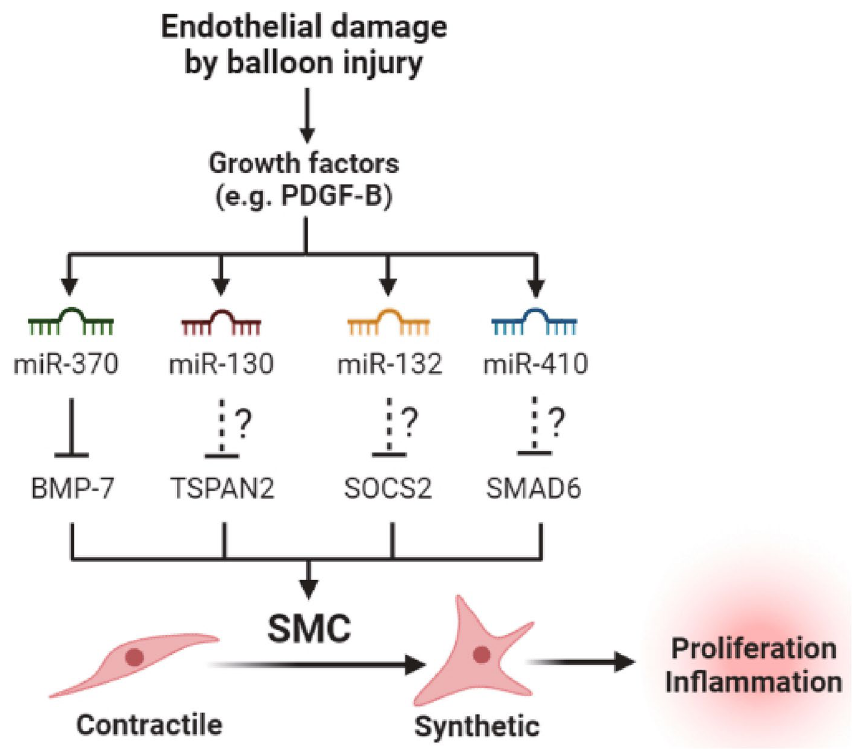
Figure 6. Model of the miRNA-mediated regulation of SMC phenotypes. Endothelial damage by arterial injury triggers growth factor-mediated induction of four miR candidates in the arterial SMCs. Those miR